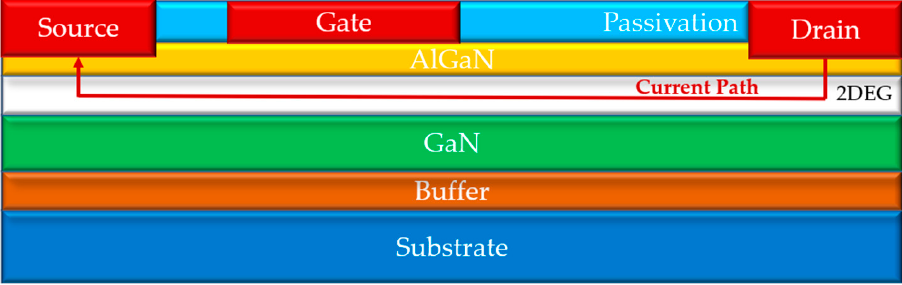
Figure 1. Depletion-mode lateral GaN HFET.